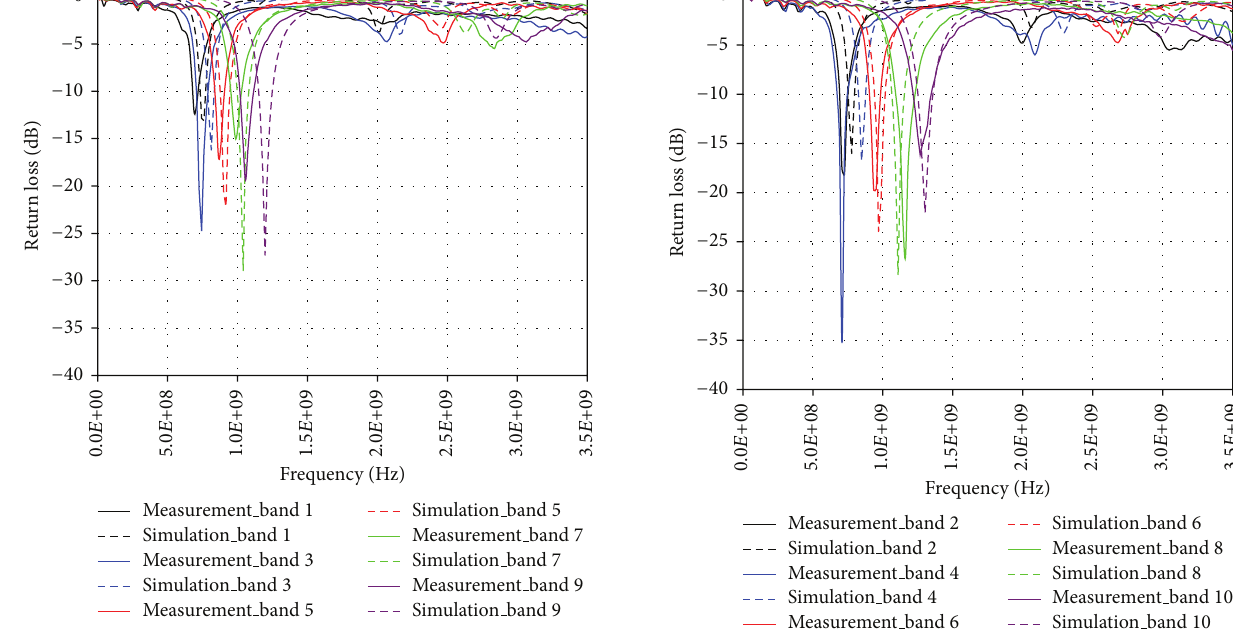
Figure 4: Simulated and measured return losses at Bands 2, 4, 6, 8, and